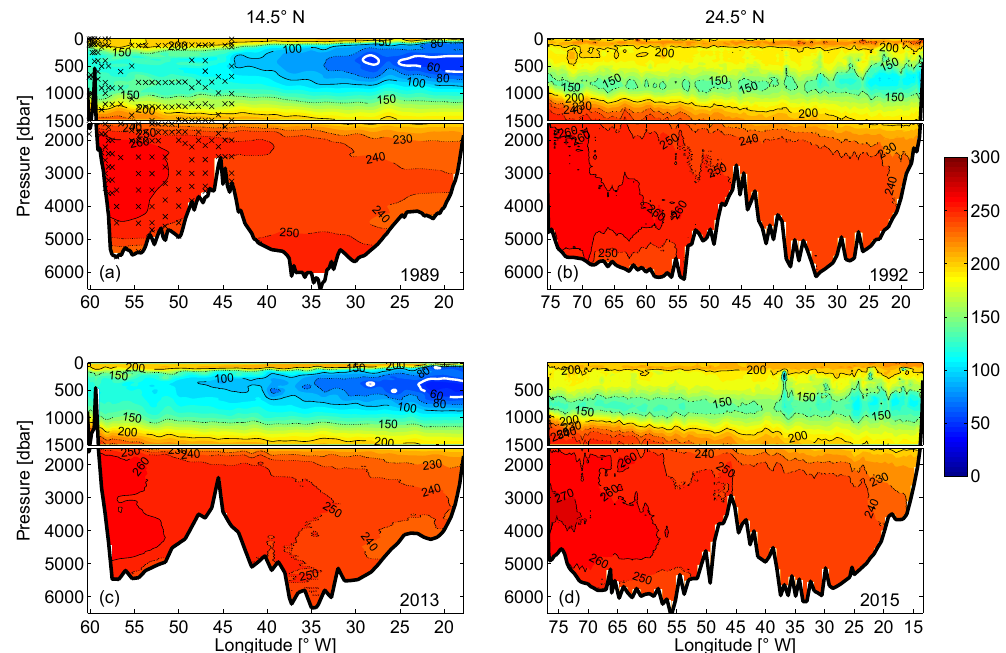
Figure 5. Vertical sections of oxygen (µmolkg − 1 ) at 14.5 ◦ N in (a) 1989 and (c) 2013 and at 24.5 ◦ N in (b) 1992 and (d) 2015. The “crosses” in (a) mark the positions of bottle oxygen data, which are used to reconstruct the oxygen section in the western basin (see text for details). The white contour in (a) and (c) marks the 60µmolkg − 1 oxygen. The upper 1500m in each subplot is